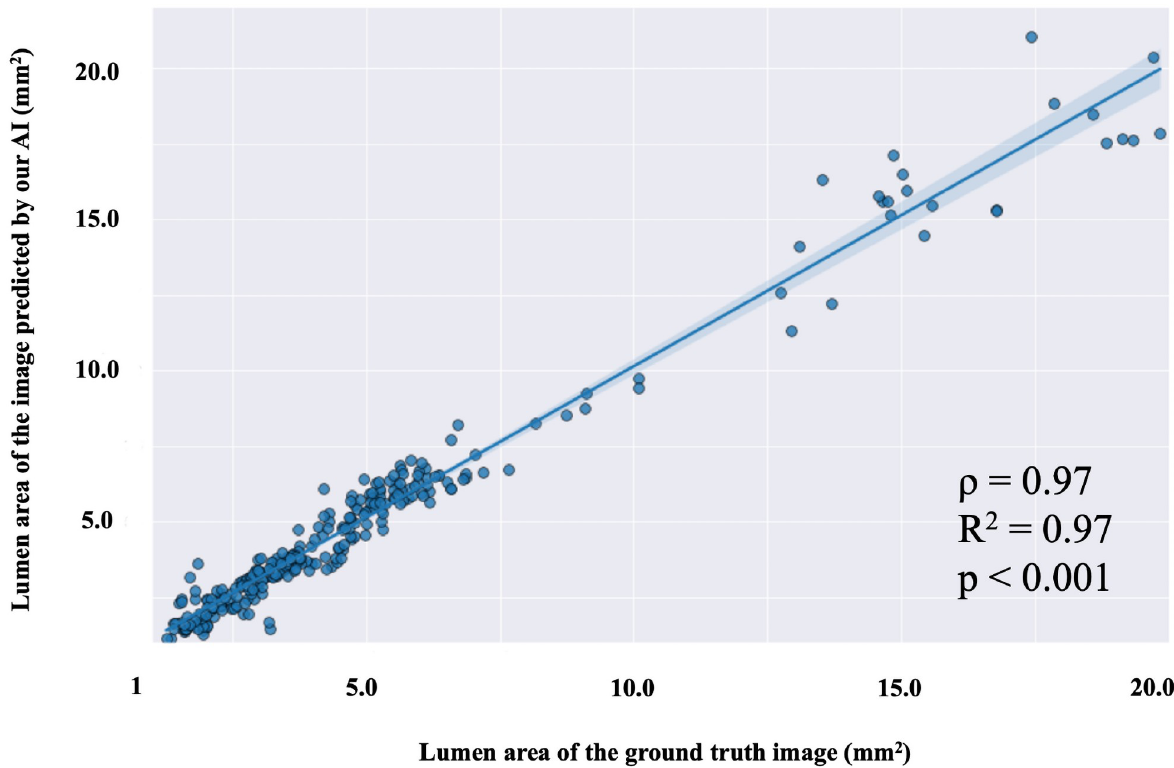
Fig 4. Scatter plot showing a regression line for the lumen area in ground truth mask images and the lumen area in mask images predicted by our AI. The light blue area shows the 95% confidence intervals of the regression line. Lumen areas of mask images predicted by our AI and lumen areas of ground truth mask images show a strong positive correlation (Spearman rank